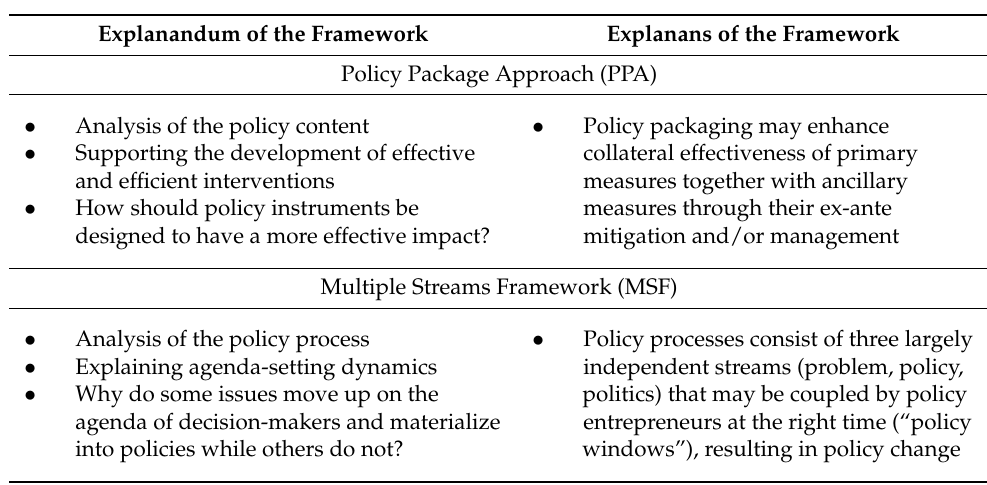
Table 1. Interplay and description of selected theoretical